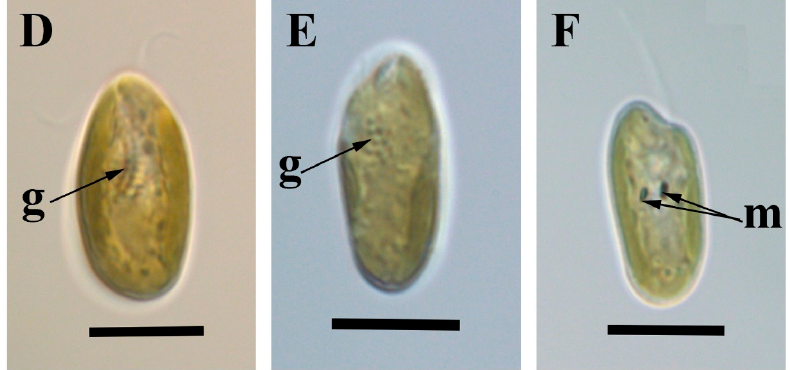
Figure 2. Light micrographs of Cryptomonas tropica sp. nov. (strain Vp 376). ( A ) Ventral view; ( B – D ) Dorsal view; ( E ) Lateral view, left side; ( F ) Lateral view, right side. Scale bar − 10 µm. f—flagellas, g—furrow-gullet system, m—Maupas ovals. Phylogenetic relationships inferred from concatenated dataset of nuclear-encoded SSU, LSU rDNA, and plastid-encoded psb A using ML and BI, show that these strains have identical sequences and form an independent long branch in the tree (Figure 3).